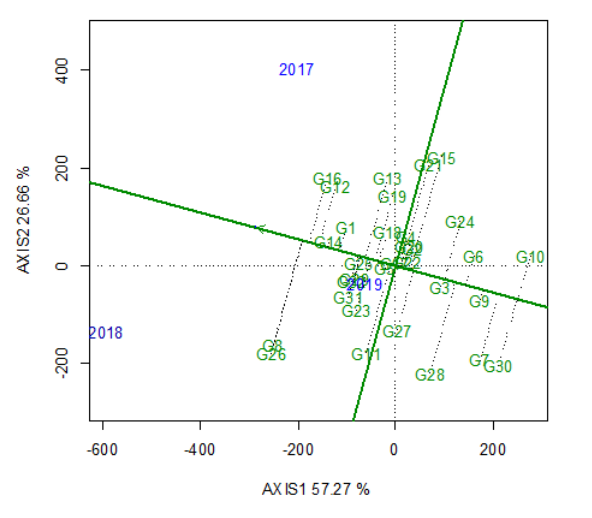
Figure 4 A Genotype × Environment interaction effects biplot representing the Means × Stabilities that indicate the yield rankings of the 32 assessed barley accessions. Accessions G8 and G26 have the highest mean yields, followed by G12 and G16, whereas G10 and G30 have the lowest mean yield. Genotype G8 and G26 were highly unstable, whereas G20 and G22 were highly